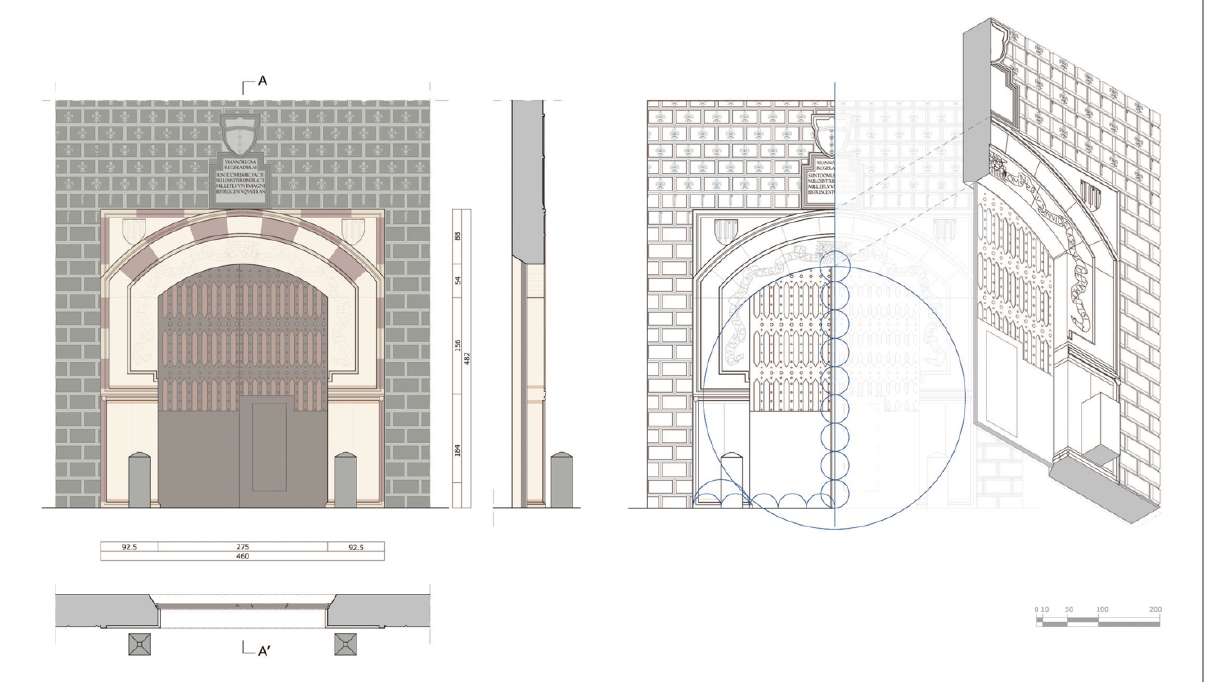
Figure 1. Palazzo Penne, entrance portal, drawings by Giuseppe